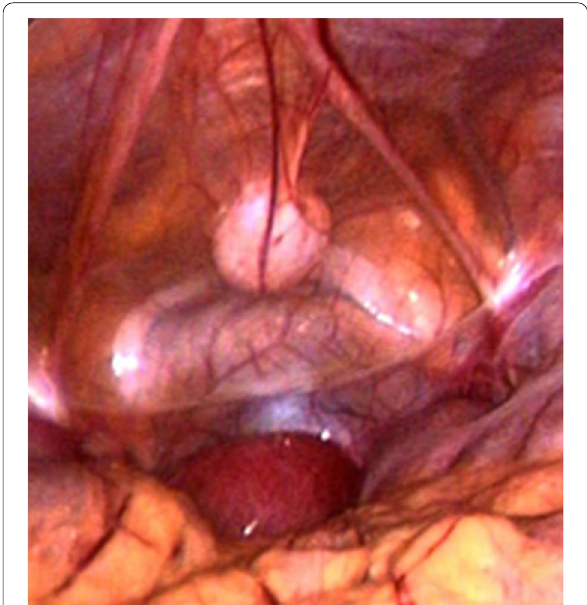
Fig. 5 Signs of chronic